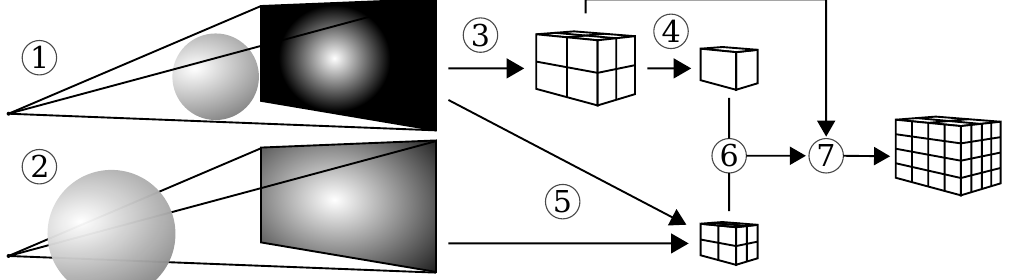
Figure 2. Method summary. We make a high- and low-resolution reconstruction of a region of interest to train a neural network to obtain a high-resolution representation of the entire object. (1) Acquire projection data; (2) Acquire zoomed in projection data; (3) Reconstruct on a coarse grid; (4) Restrict to a region of interest; (5) Reconstruct the region of interest on a fine grid using both projection datasets; (6) Train a neural network to transform the low-resolution region of interest to a high-resolution volume; (7) Apply the network to the entire low-resolution